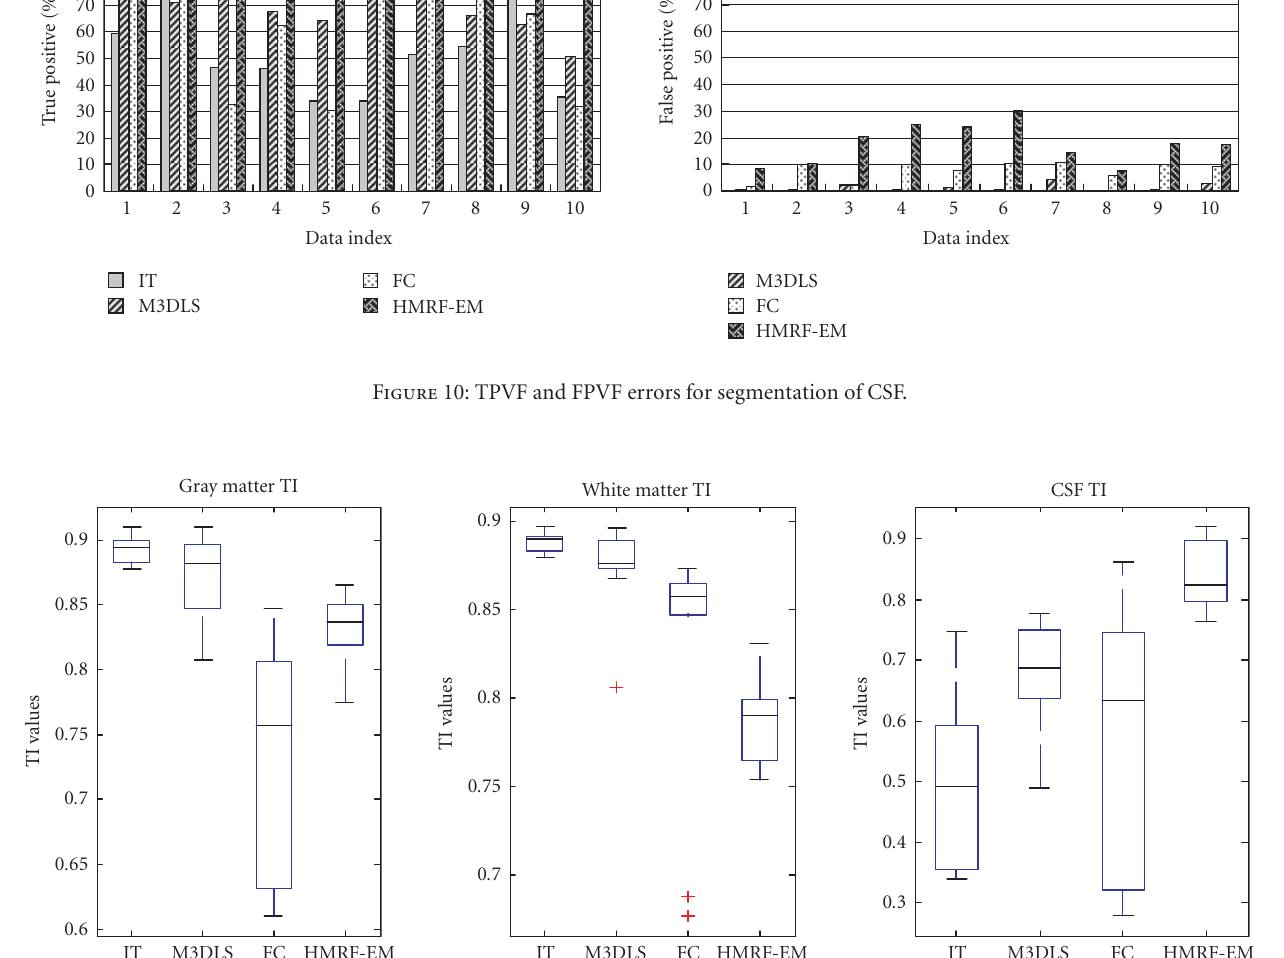
HMRF-EMFCM3DLSIT0 .